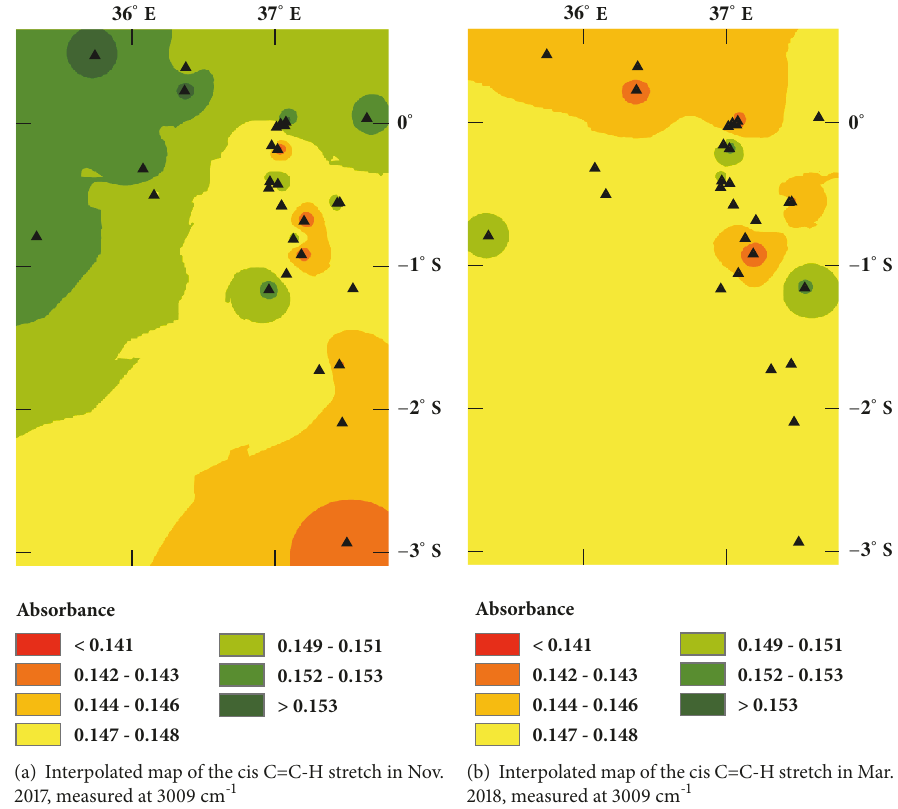
(a) Interpolated map of the cis C=C-H stretch in Nov. 2017, measured at 3009 cm - 1